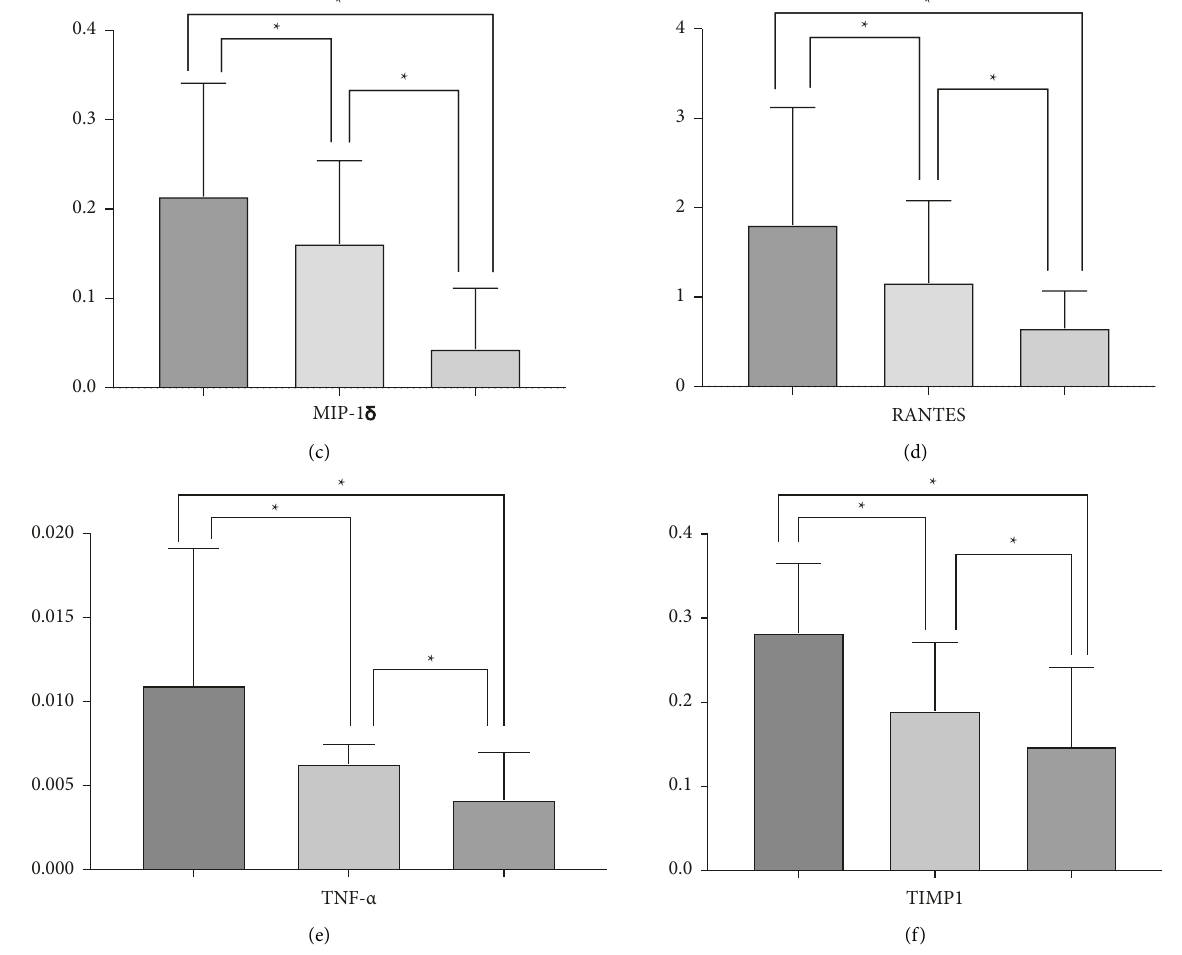
Figure 3: Pairwise comparisons were performed using Student’s t -test. Comparisons of MIP-1 δ , MCP-2, TIMP-1, RANTES, IGFBP3, and TNF- α levels between the three groups. The y -axis represents a standardized cytokine expression level and ∗ represents a significant difference. MCP— P � 0 . 0021, preradiotherapy vs. postradiotherapy; P � 0 . 0155, postradiotherapy vs. healthy controls; P < 0 . 001, pre- radiotherapy vs. healthy controls. IGFBP3— P � 0 . 0067, preradiotherapy vs. postradiotherapy; P � 0 . 0097, postradiotherapy vs. healthy controls; P < 0 . 001, preradiotherapy vs. healthy controls. MIP-1 δ — P � 0 . 0067, preradiotherapy vs. postradiotherapy; P � 0 . 0097, post- radiotherapy vs. healthy controls; P < 0 . 001, preradiotherapy vs. healthy controls. RANTES— P � 0 . 0019, preradiotherapy vs. post- radiotherapy; P � 0 . 0417, postradiotherapy vs. healthy controls; P � 0 . 0263, preradiotherapy vs. healthy controls. TNF- α — P � 0 . 0019, preradiotherapy vs. postradiotherapy; P � 0 . 0417, postradiotherapy vs. healthy controls; P � 0 . 0263, preradiotherapy vs. healthy controls. TIMP-1— P � 0 . 0054, preradiotherapy vs. postradiotherapy; P � 0 . 0466, postradiotherapy vs. healthy controls; P � 0 . 0234, preradiotherapy vs. healthy